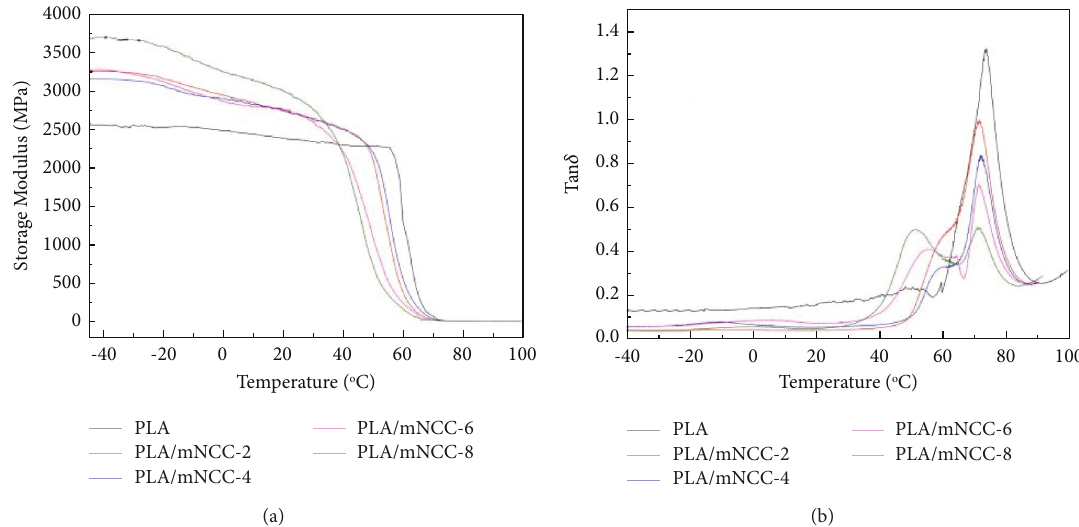
Figure 4: Dynamic thermomechanical analysis of PLA and its nanocomposites: (a) storage modulus and (b) loss factor.